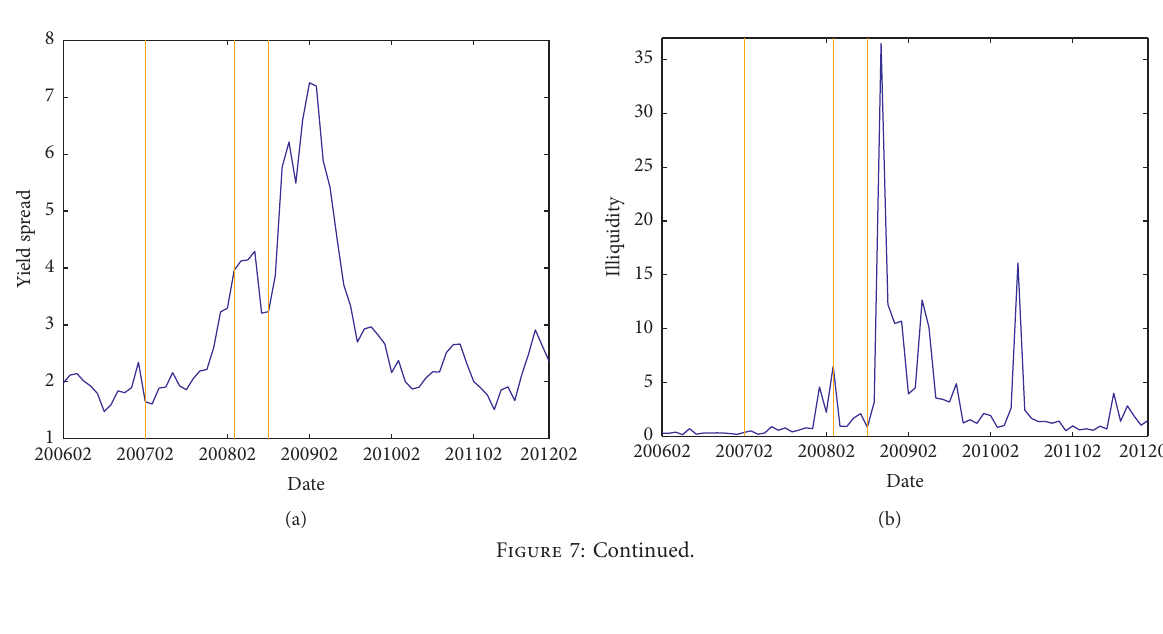
Figure 6: Smoothed states’ probabilities.